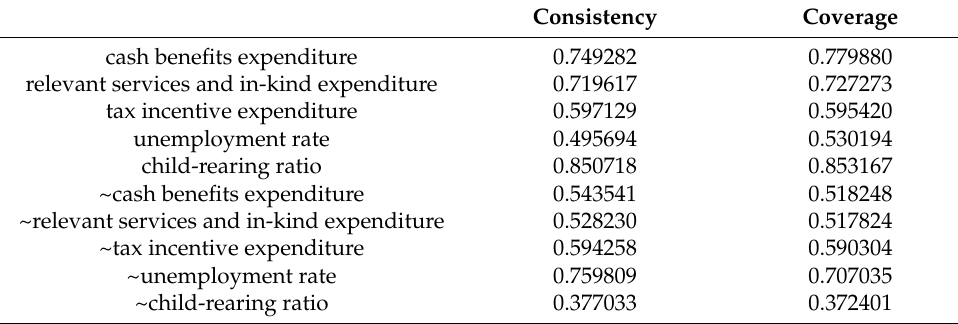
Table 9. Analysis of the necessity of conditional